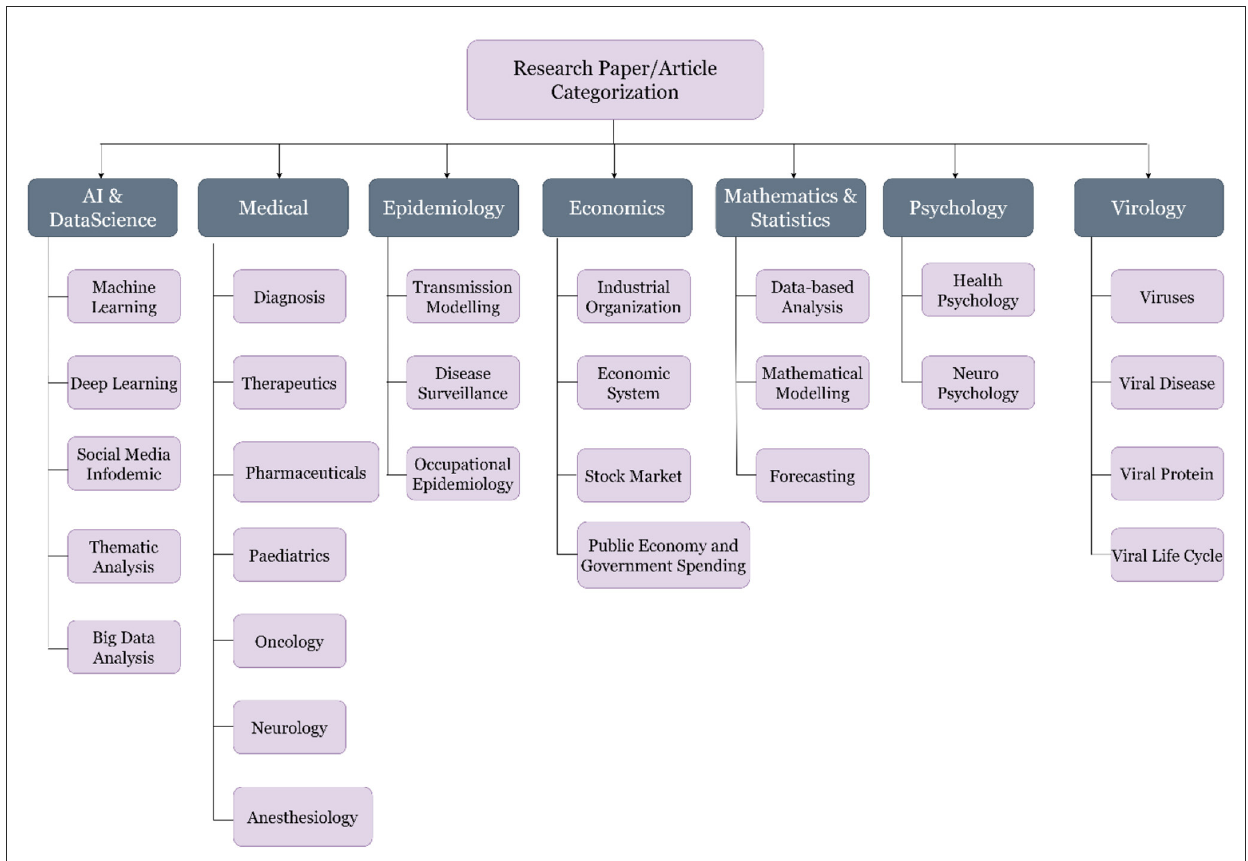
FIGURE6 Categorization and sub-categorization of the articles selected for the study.